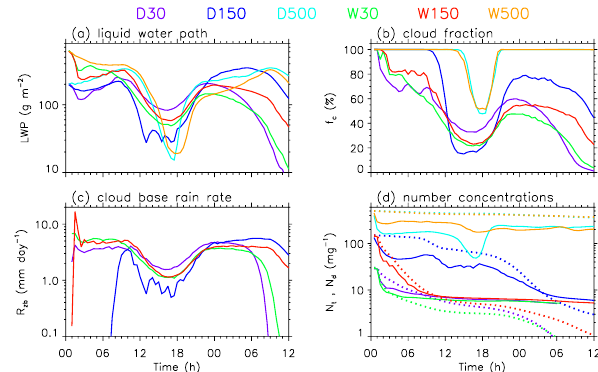
Fig. 3. Time evolution of (a) domain-average LWP; (b) cloud frac- tion; (c) domain-average cloud-base rain rate R zb ; and (d) cloud- average drop number concentration N d (solid) and boundary-layer total particle number concentration N t (dotted) for the six experi- ments as indicated in the legend. Cloudy columns are defined by optical depth > 2 for the calculation of cloud fraction; a threshold of N d =5mg − 1 is applied when calculating cloud-average N d . Cloud base in each model column is defined as the lowest grid point that has cloud water mixing ratio ≥ 0.01gkg − 1 .